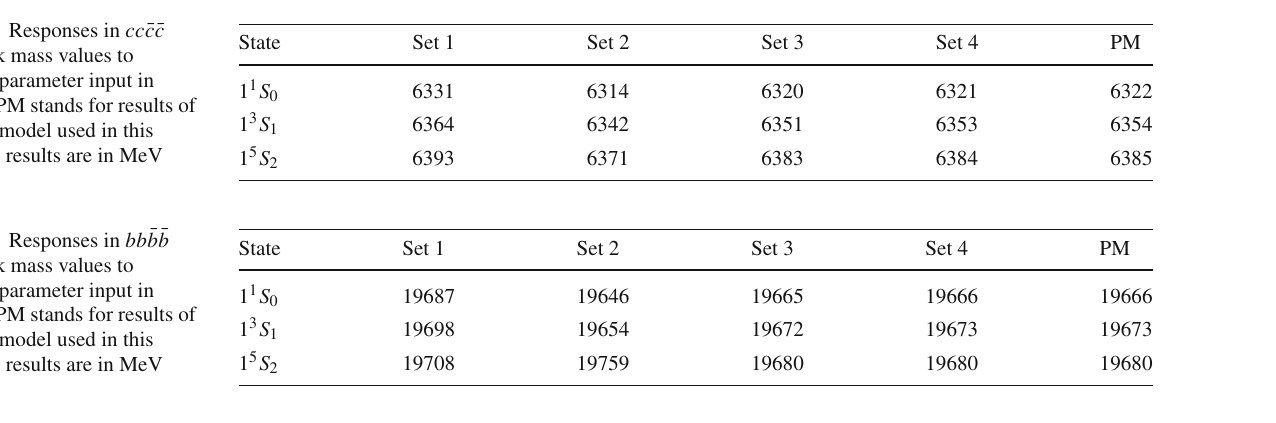
Table 13 Group 2 potential